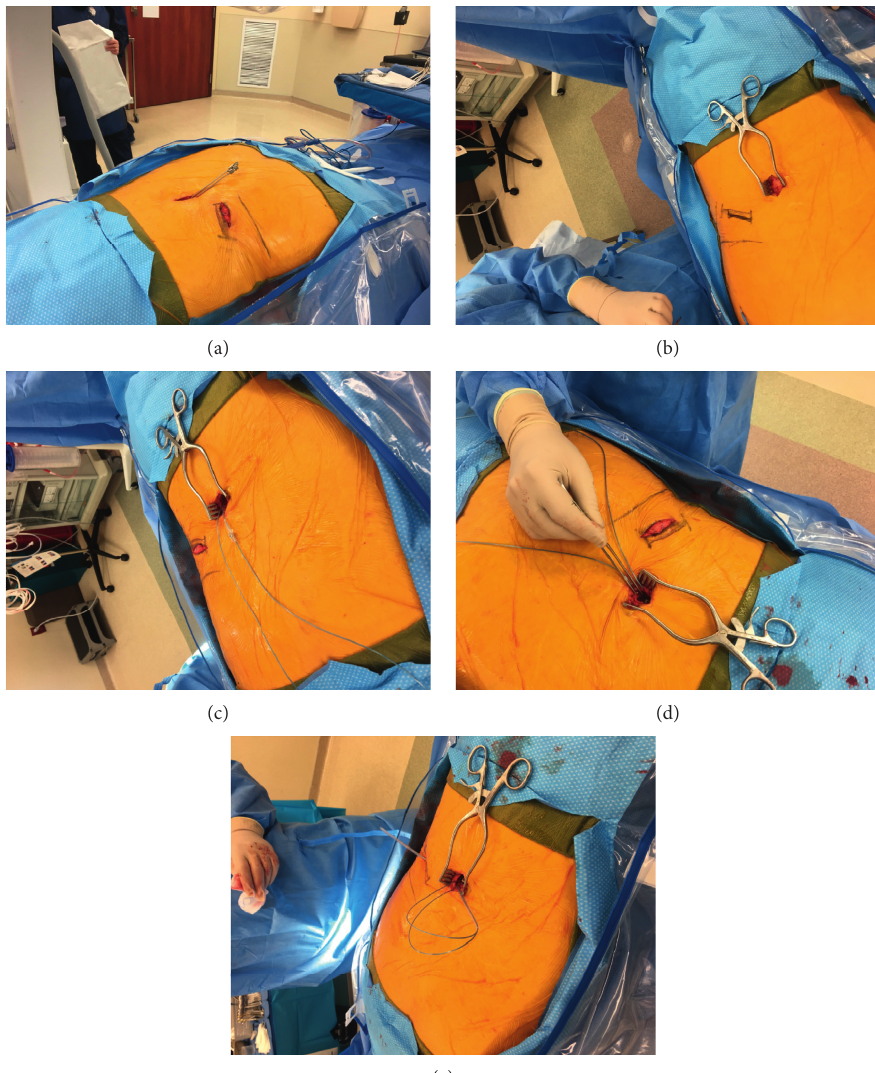
Figure 1: Surgical procedure during trial and implantation of the leads and